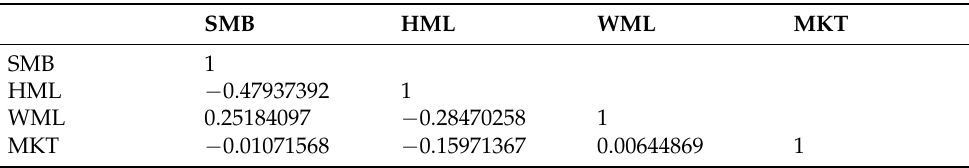
Table 2. Correlation coefficient among pricing